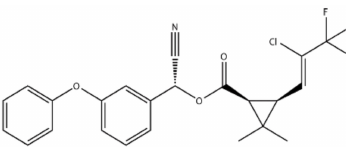
Figure 1. Chemical structure of